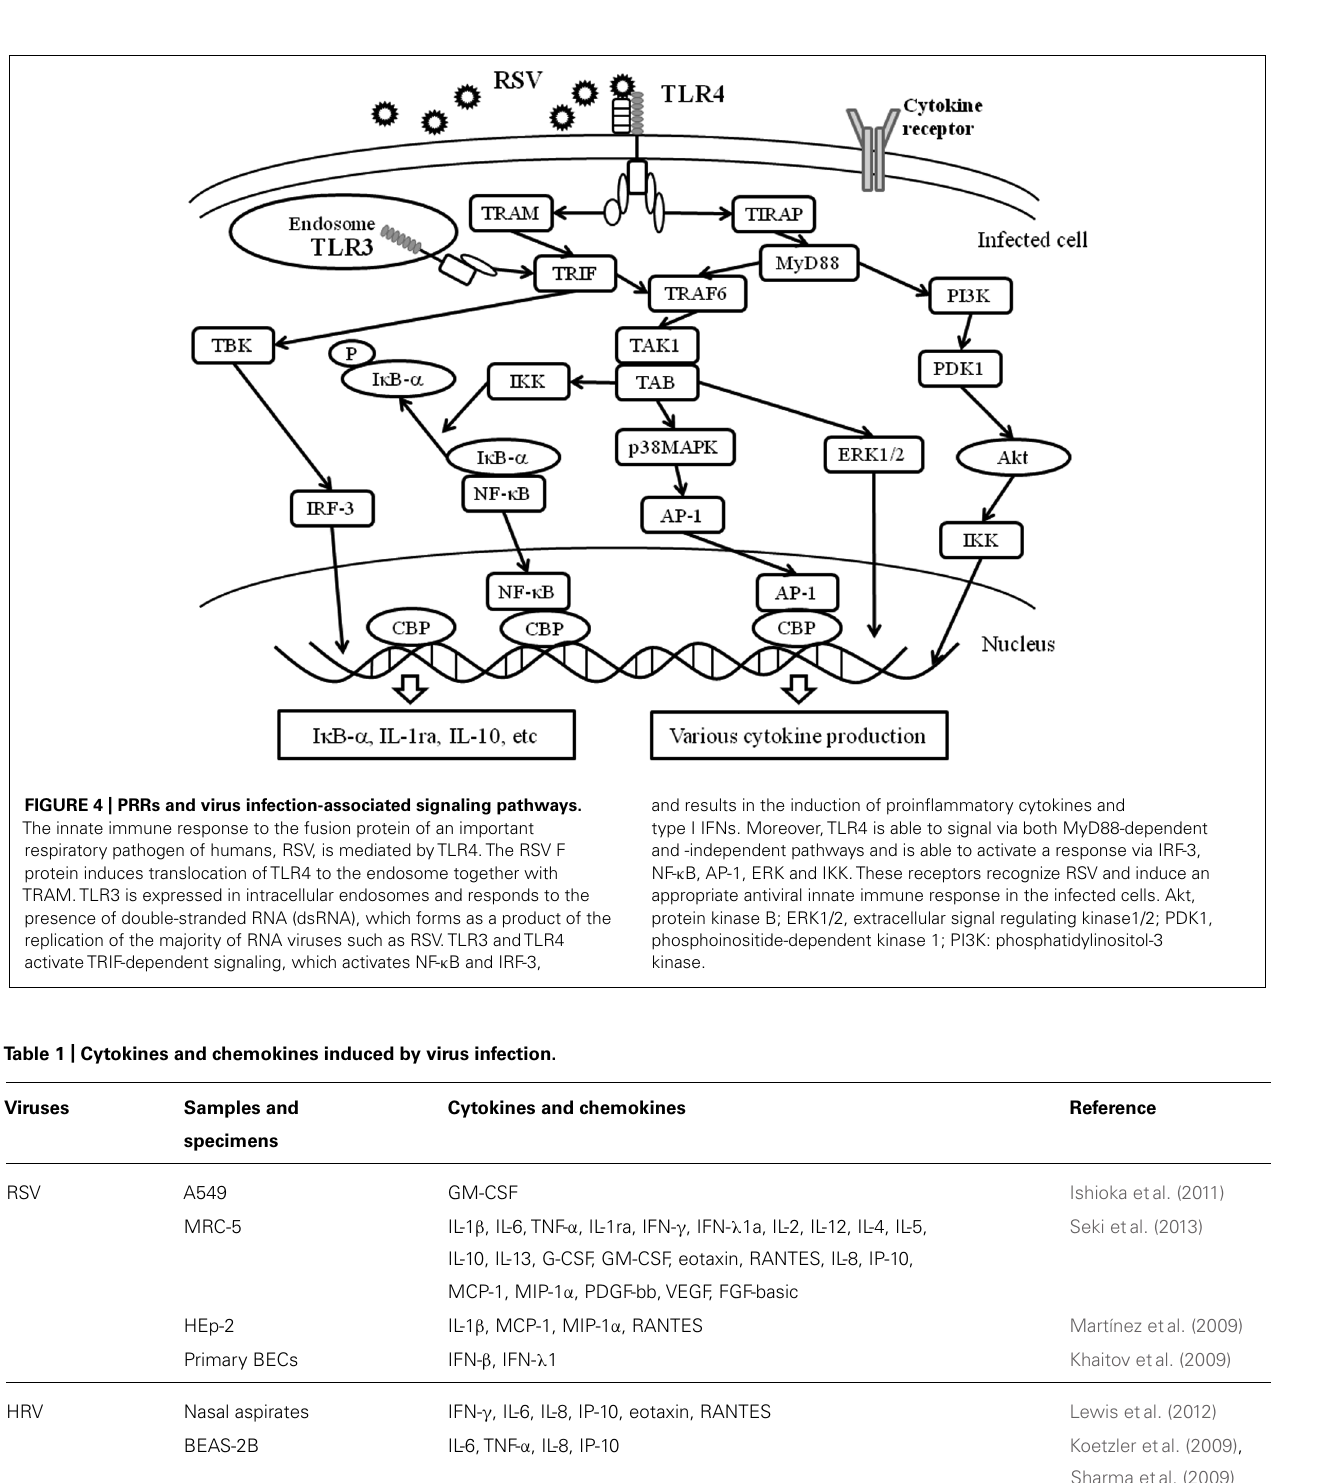
Table 1 | Cytokines and chemokines induced by virus